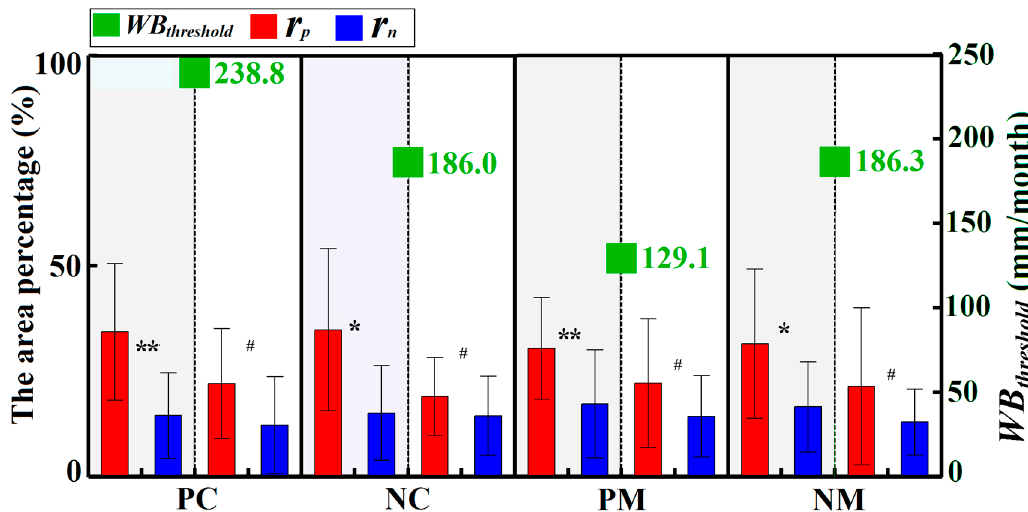
Figure 9. The differences in area percentages between significant positive and negative correlations on both sides of the water balance threshold ( WB threshold ) during the pregrowing season. The **, *, and # indicate difference significant at p < 0.01, significant at p < 0.05, and not significant at p < 0.05, respectively. The PC, PM, NC, and NM represent planted coniferous, planted mixed, natural coniferous, and natural mixed forests, respectively. The whiskers of the bar represent the standard deviation of related data.